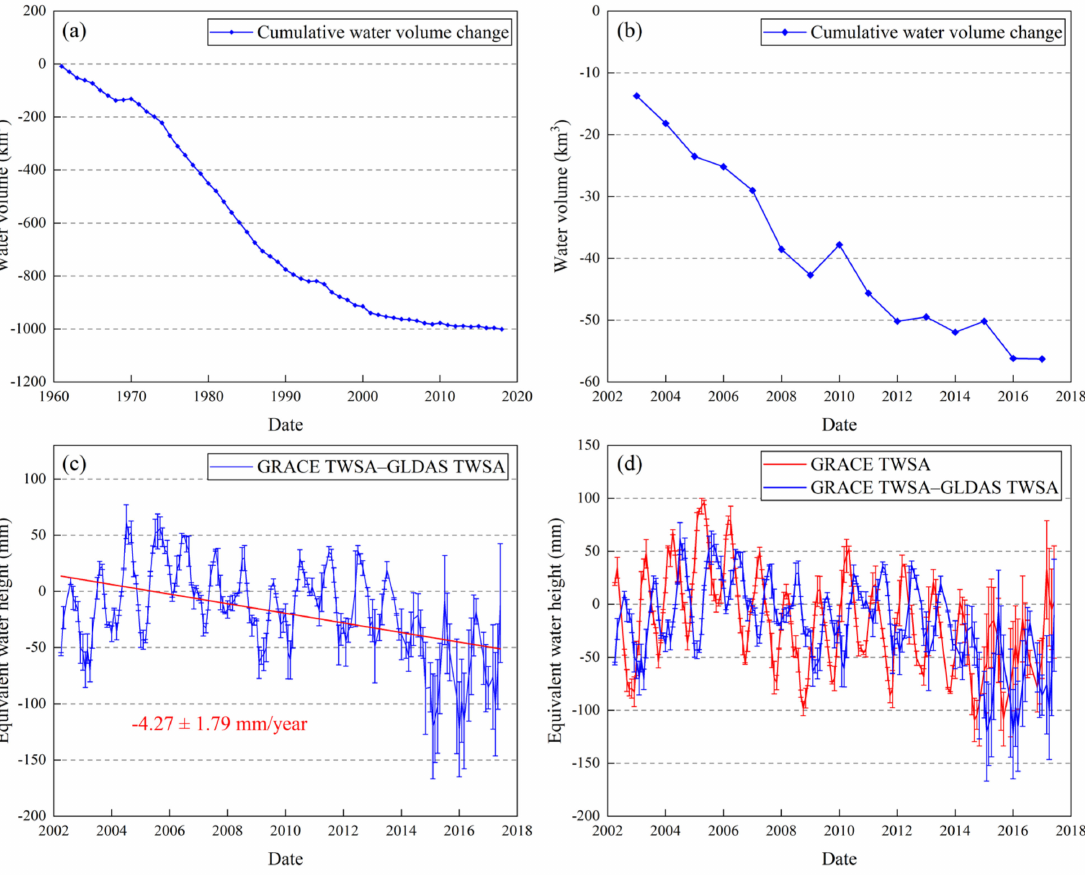
Figure 9. Variations in water volume of the Aral Sea during the periods of 1960–2018 ( a ) and 2002–2017 ( b ), variations in GRACE TWSA–GLDAS TWSA of the Aral Sea Basin during 2002–2017 ( c ), and the comparison of GRACE TWSA and GRACE TWSA–GLDAS TWSA ( d ). The blue bars represent the data